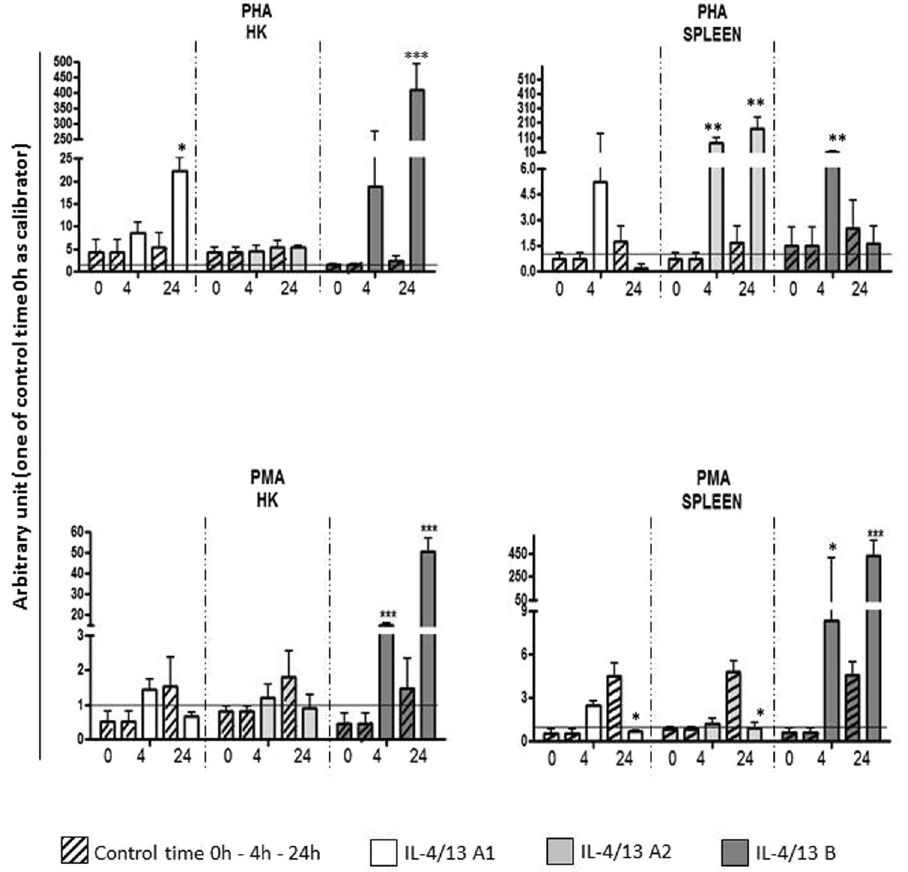
Figure 4. The expression of sea bass IL-4/13 isoforms after in vitro stimulation with PHA and PMA. The mRNA levels of sea bass IL-4/13 isoforms were normalised to that of 18S rRNA in the same samples after real-time PCR analysis of HK and spleen leukocytes stimulated with L-15 medium (control) or with 10 µ g/ml of PHA or with 1 µ g/ml PMA for 4 h and 24 h, and expressed as arbitrary unit against the non-stimulated 0 h control. Data were expressed as the mean + SD. * p < 0.05 with respect to the time 0 control; ** p < 0.01 with respect to the time 0 control; *** p < 0.001 with respect to the time 0 control; N = 4.